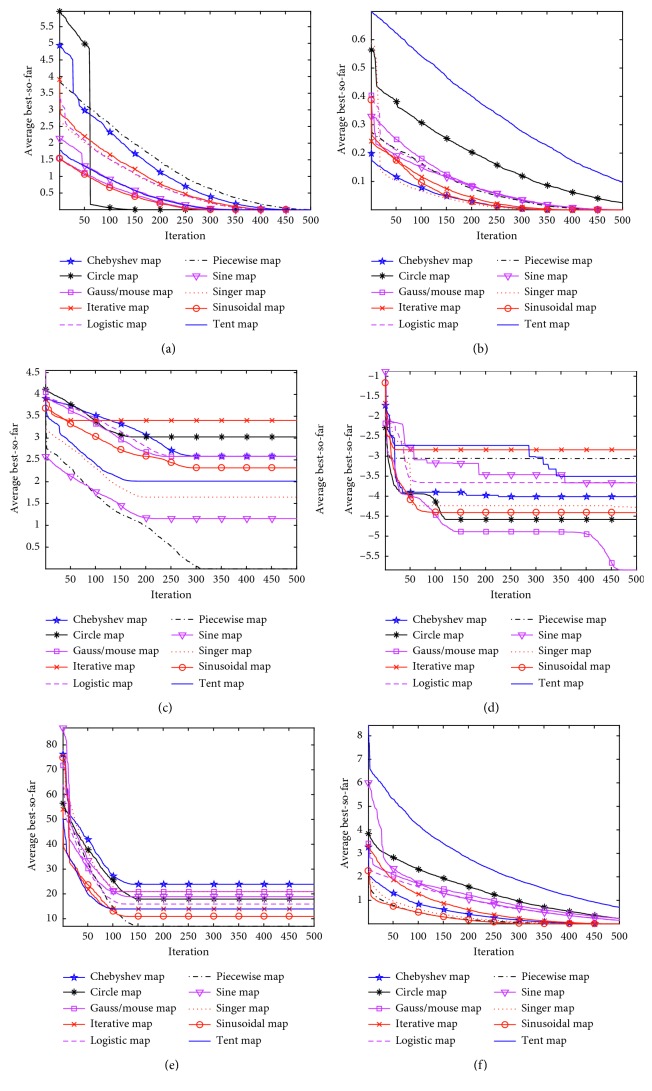
Convergence curves under ten chaotic mappings. (a) F1. (b) F2. (c) F3. (d) F4. (e) F5. (f) F6.